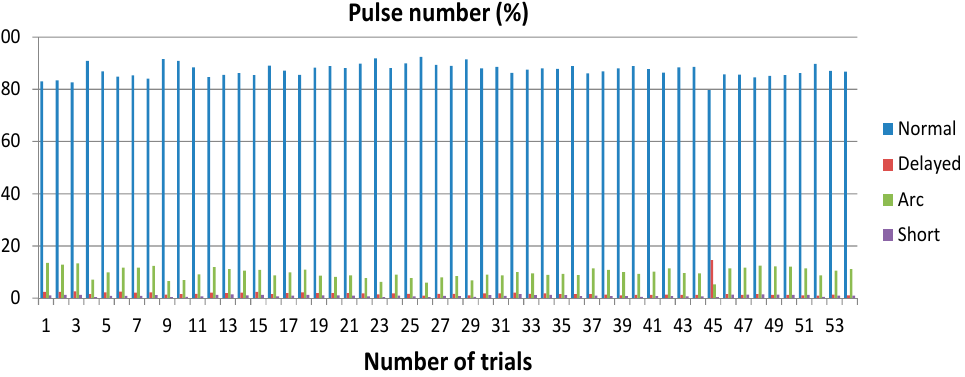
Figure 5. Number of normal, arc, short, and delayed pulses reported in percentage.